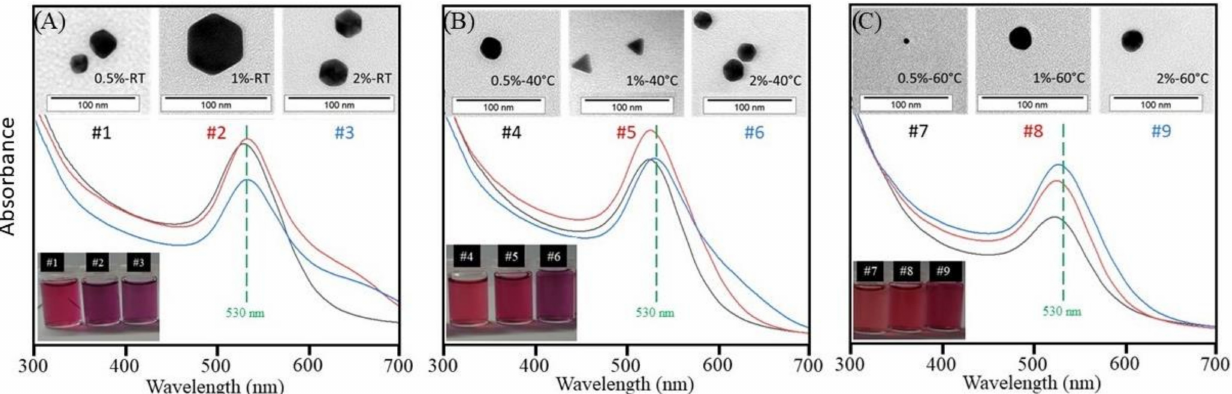
Figure 2. UV-vis spectra of AuNP solutions. In the inset: images of solutions and TEM-images of nanoparticles formed: ( A ) at room temperature and acetic acid concentration of 0.5, 1, and 2%; ( B ) at 40 ◦ C and acetic acid concentration of 0.5, 1, and 2%; and ( C ) at 60 ◦ C and acetic acid concentration of 0.5, 1, and